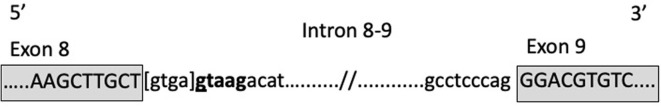
Graphic description of the TSHR donor splice site variant in case 33. [] means deleted bases; bold font indicates splice site after deletion.